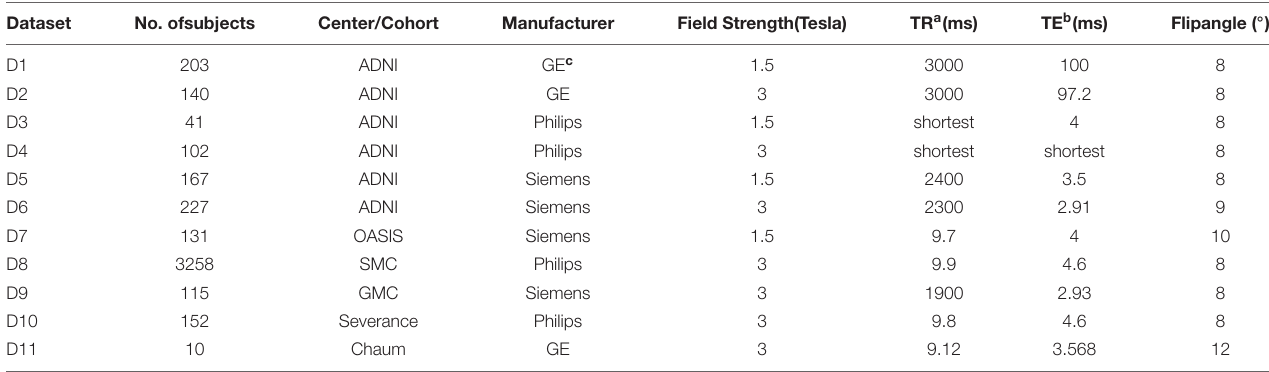
TABLE 1 | Scan parameters for T1-weighted magnetic resonance imaging (MRI) of each dataset.